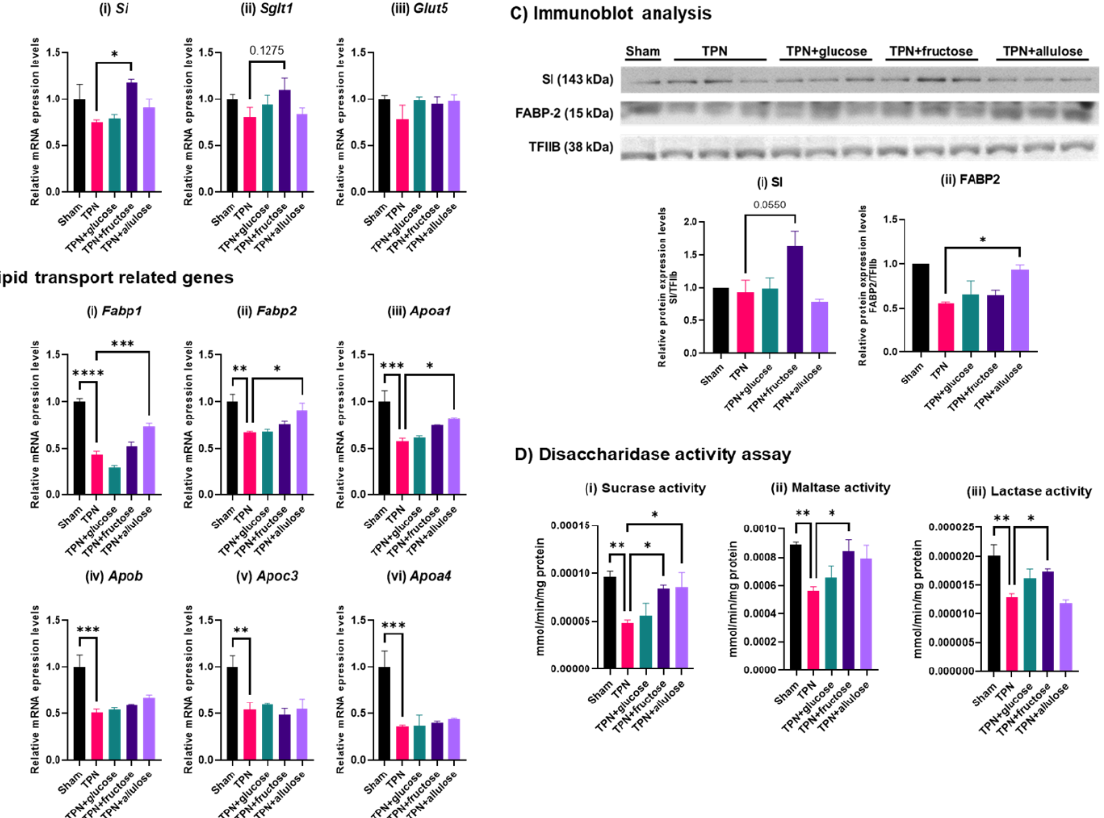
Figure 6. mRNA expression and protein and activities of representative genes involved in digestion and absorption of nutrients in TPN model of rats. ( A ) Results of qRT-PCR for carbohydrates digestion/absorption relate genes, ( i ) Si , ( ii ) Sglt1 and ( iii ) Glut5. ( B ) Results of qRT-PCR for lipid transport related genes, ( i ) Fabp1 , ( ii ) Fabp2 , ( iii ) Apoa1 , ( iv ) Apob , ( v ) Apoc3 and ( vi ) Apoa4 . Values indicate mean ± SEM ( n = 4). ( C ) Results of immunoblot analysis for sucrase-isomaltase complex (SI) and fatty acid binding protein 2 (FABP2). Transcriptional factor IIB (TFIIB) is internal control. The graphs indicate relative protein expression levels when the value of Sham group is 1.0., ( i ) SI and ( ii ) FABP2. Values indicate mean ± SEM ( n = 3). ( D ) Results of disaccharidase activity assay. ( i ) sucrase activity, ( ii ) maltase activity and ( iii ) lactase activity. Values indicate mean ± SEM ( n = 4). Asterisks indicate significant differences tested using the ANOVA-Dunnett’s multiple comparisons test (vs. TPN group, **** p < 0.0001, *** p < 0.001, ** p < 0.01, * p < 0.05).